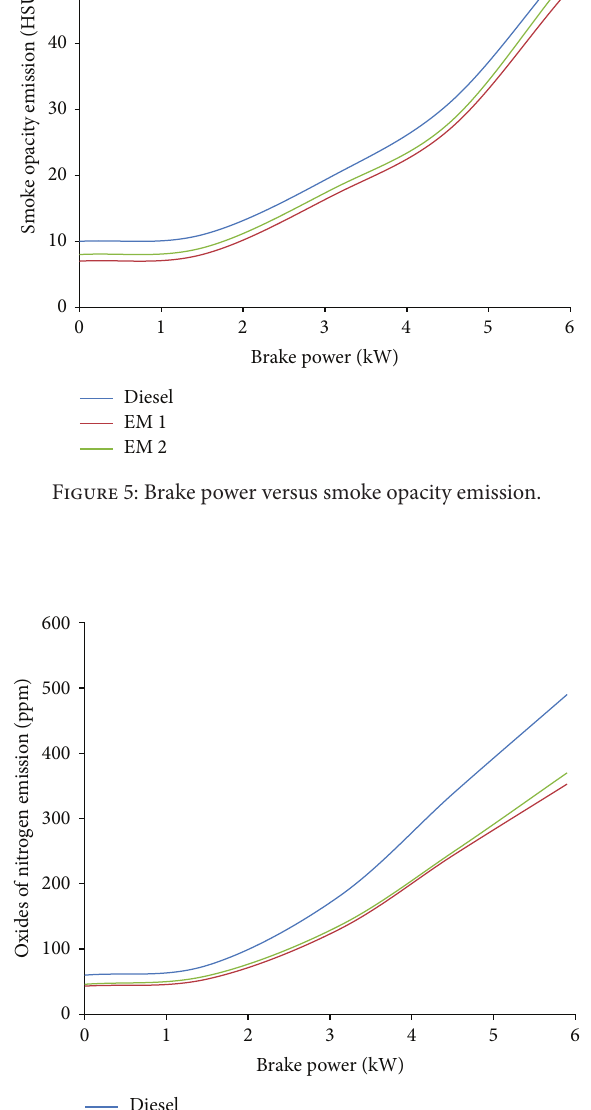
discussed that the increase in delay period improved the hence the reduction of smoke